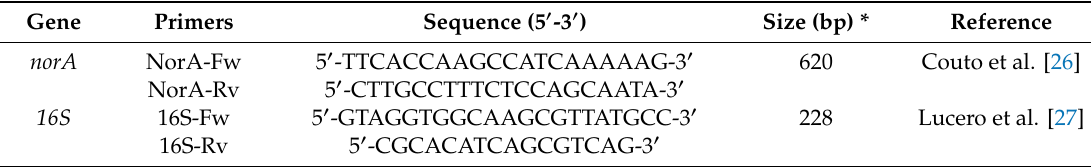
Table 1. Primers used in this